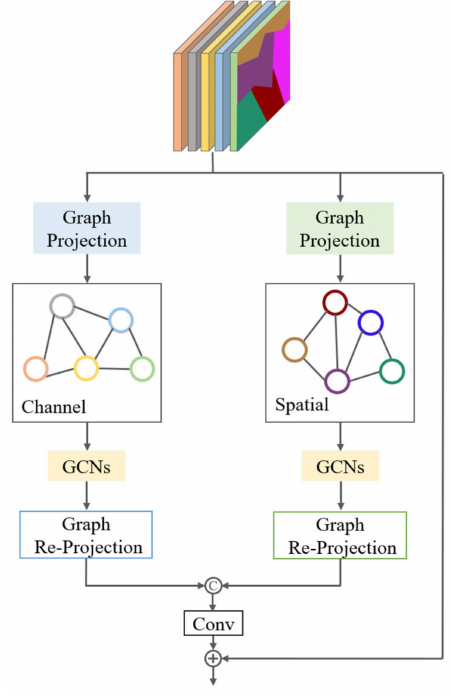
Figure 4. Semantic information supplement module (SIS